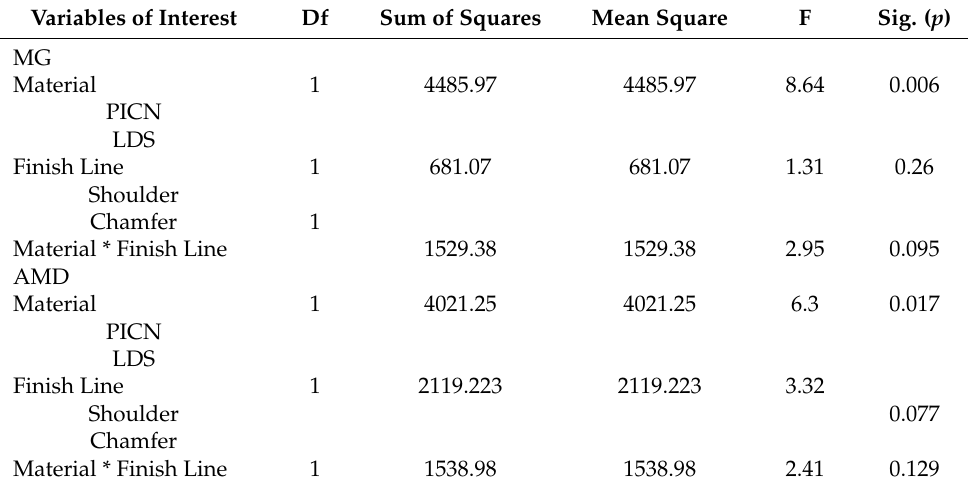
Table 2. Two-way ANOVA for MG and